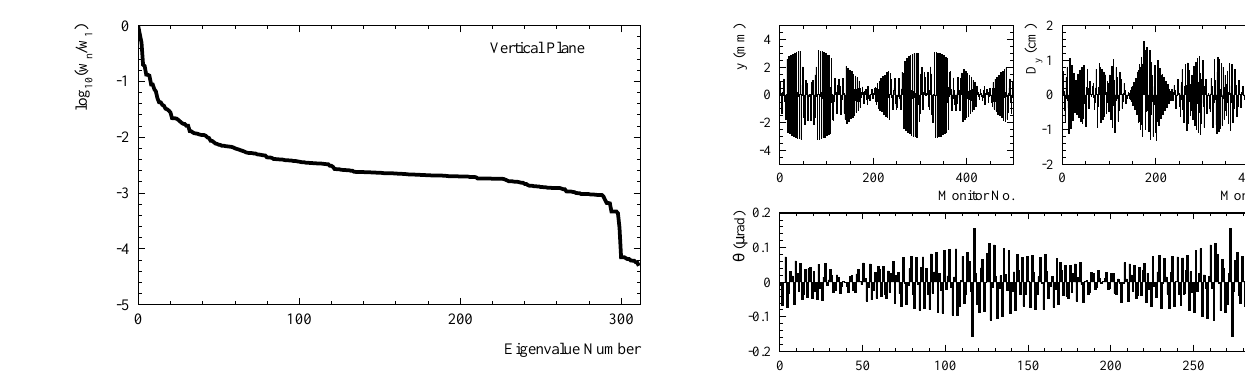
FIG. 2. Orbit eigenvalue spectrum for LEP in the vertical plane with a (cid:1) 0.2 and b (cid:1) 0 . The last four eigenvalues correspond to singular solutions in the low-beta sections around the inter- action points.